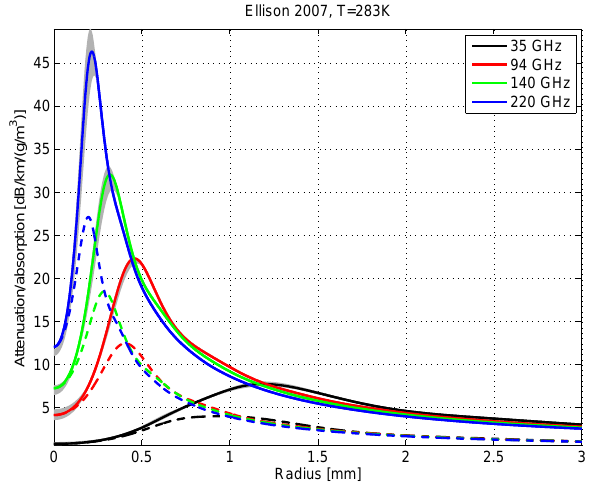
Fig. 2. Mass absorption (dashed) and attenuation (continuous lines) coefficient as a function of particle radius Figure 2. Mass absorption (dashed) and attenuation (continuous